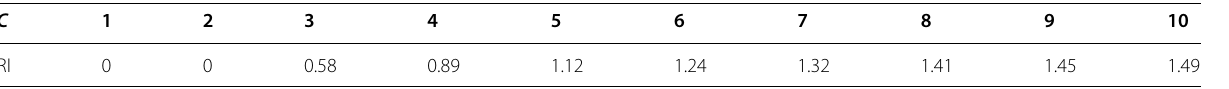
Table 3 RI value of consistency index for various number of input criteria( C ) used developed by (Saaty